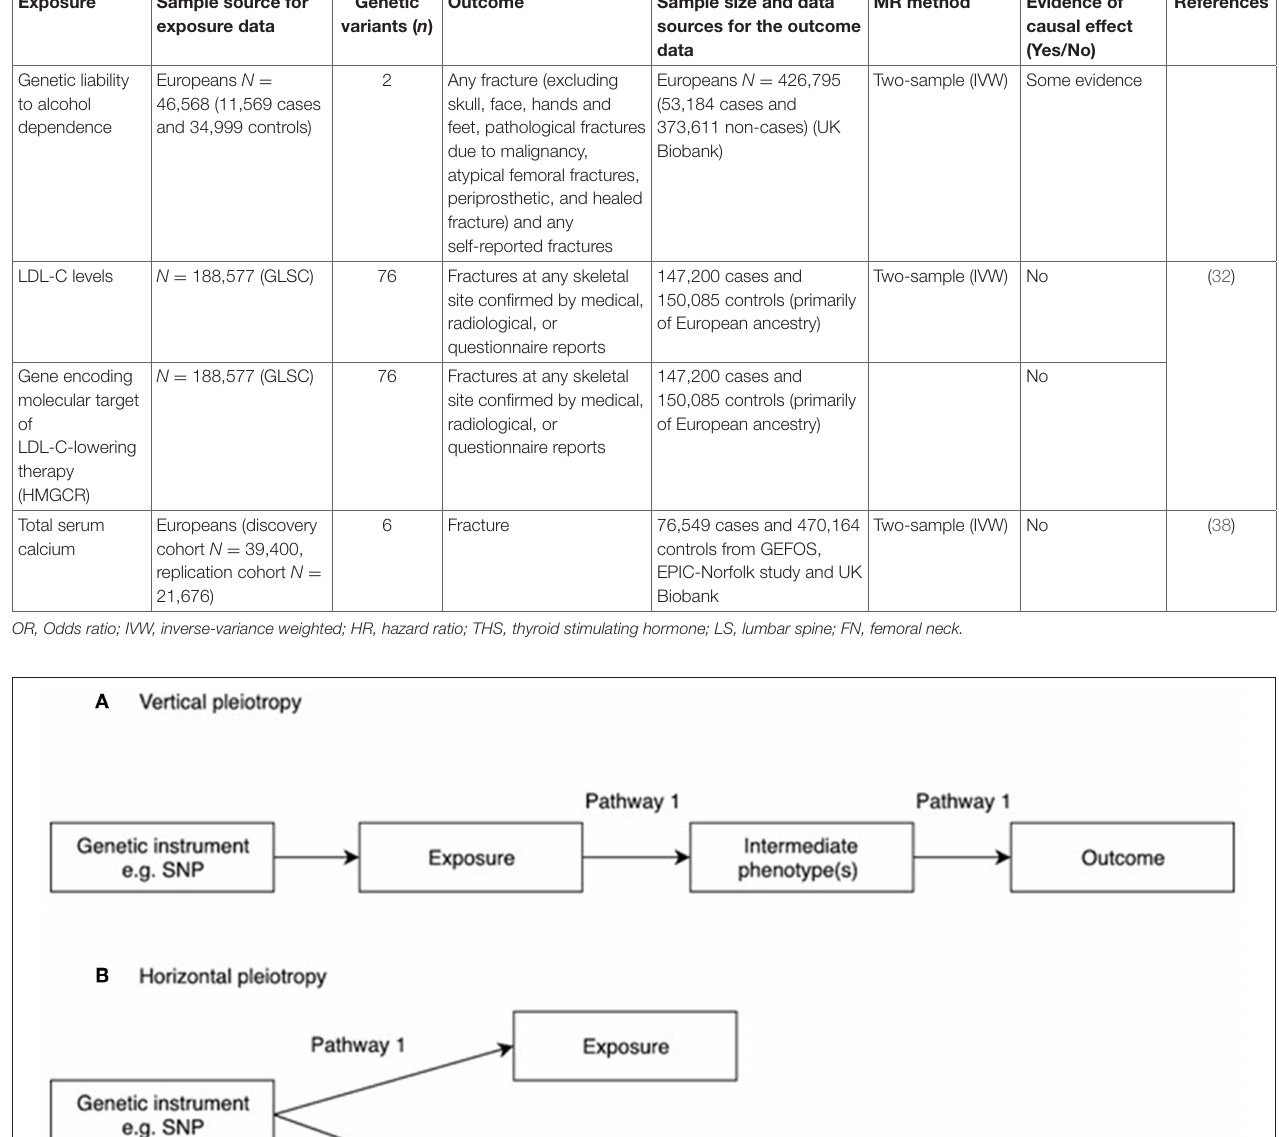
that only a certain proportion of the genetic instruments have a horizontal pleiotropic effect. These methods aim to reduce heterogeneity by removing SNPs that contribute to heterogeneity disproportionately, based on the standard errors of the Wald ratios. Such outlier removal strategies are applied in the MR- PRESSO (50), and generalized summary MR (GSMR)